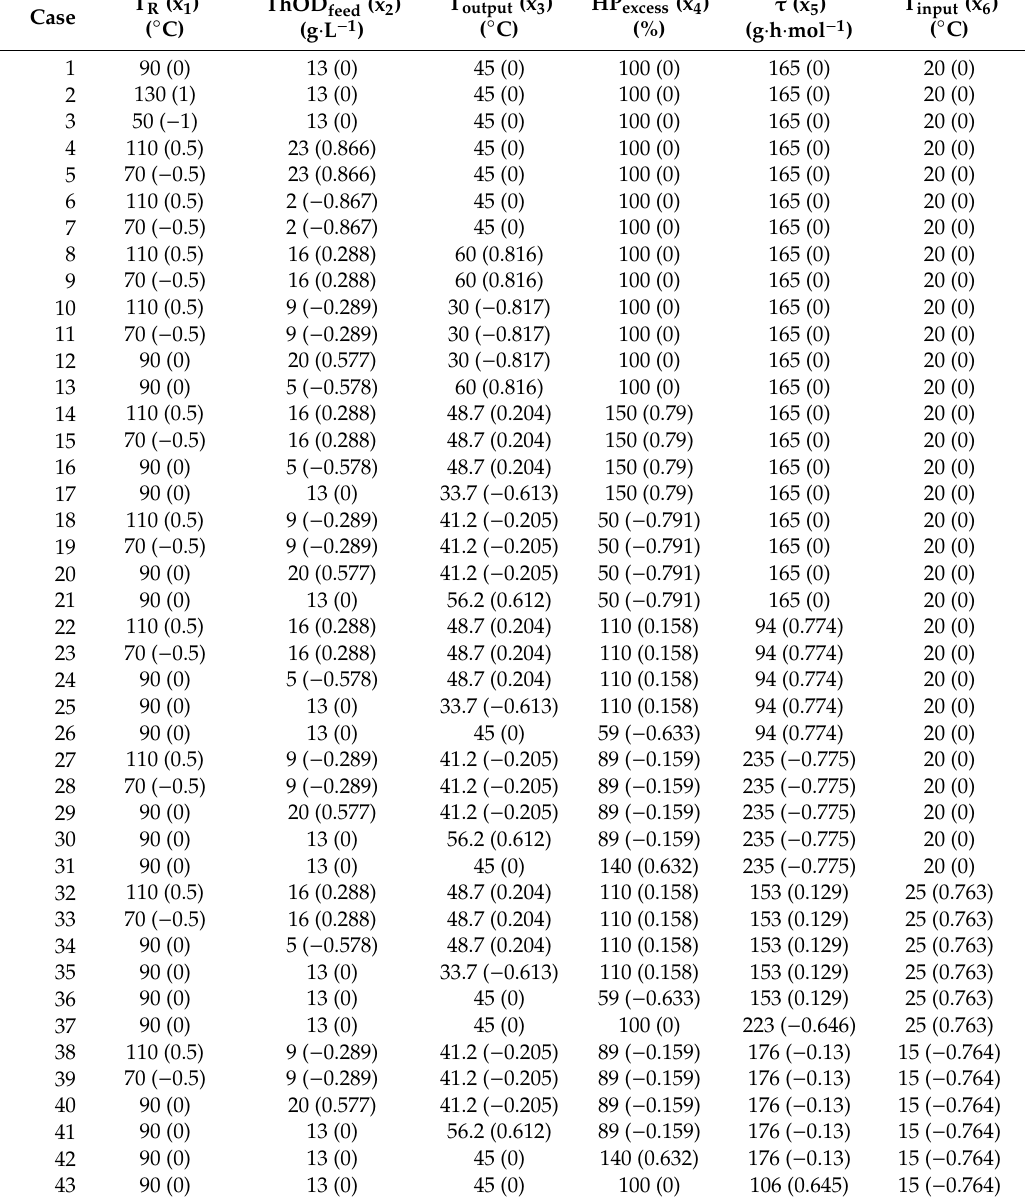
Table 1. Design of experiments based on the six-factor Doehlert Matrix. The codified values are in